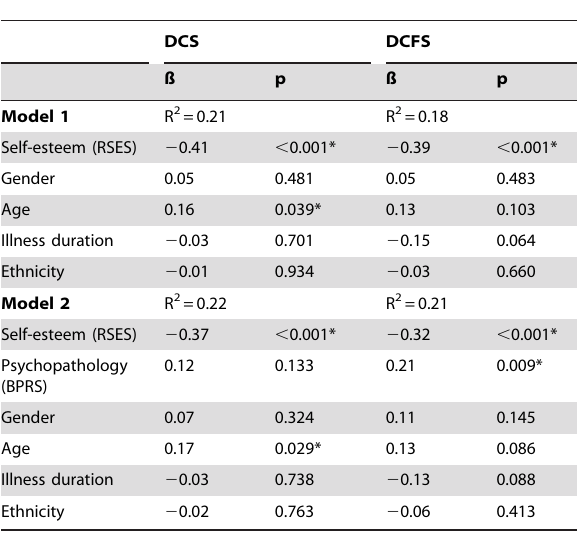
Table 3. Results of linear regression analyses on stereotype awareness